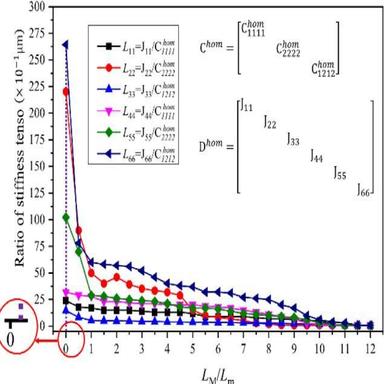
The Constitutive constants for optimal RVE solids and L M /Lm.